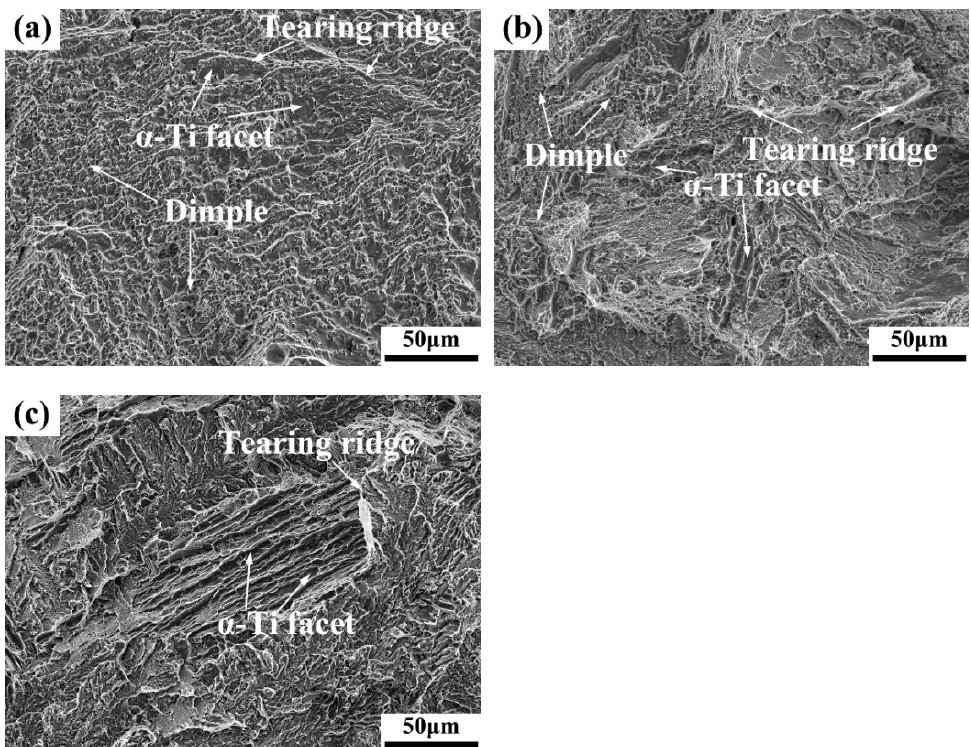
Figure 9. SEM fractographs of the tensile test specimens: ( a ) Ti-4Cu alloy; ( b ) Ti-7Cu alloy; ( c ) Ti-10Cu alloy.